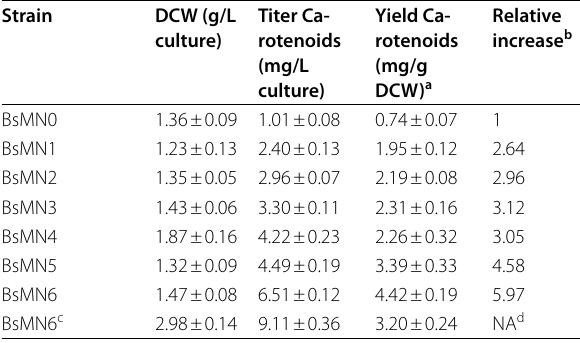
Table 2 Comparison of dry cell weight, titer and yield of C carotenoids produced by engineered B. subtilis strains and relative increase compared to the control strain Strain